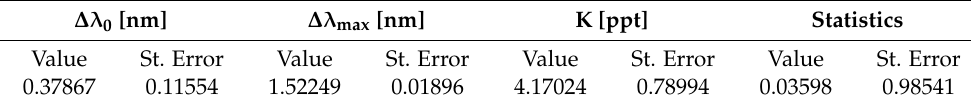
Table 3. The Langmuir parameters relative to the PFOA detection in simulated seawater.